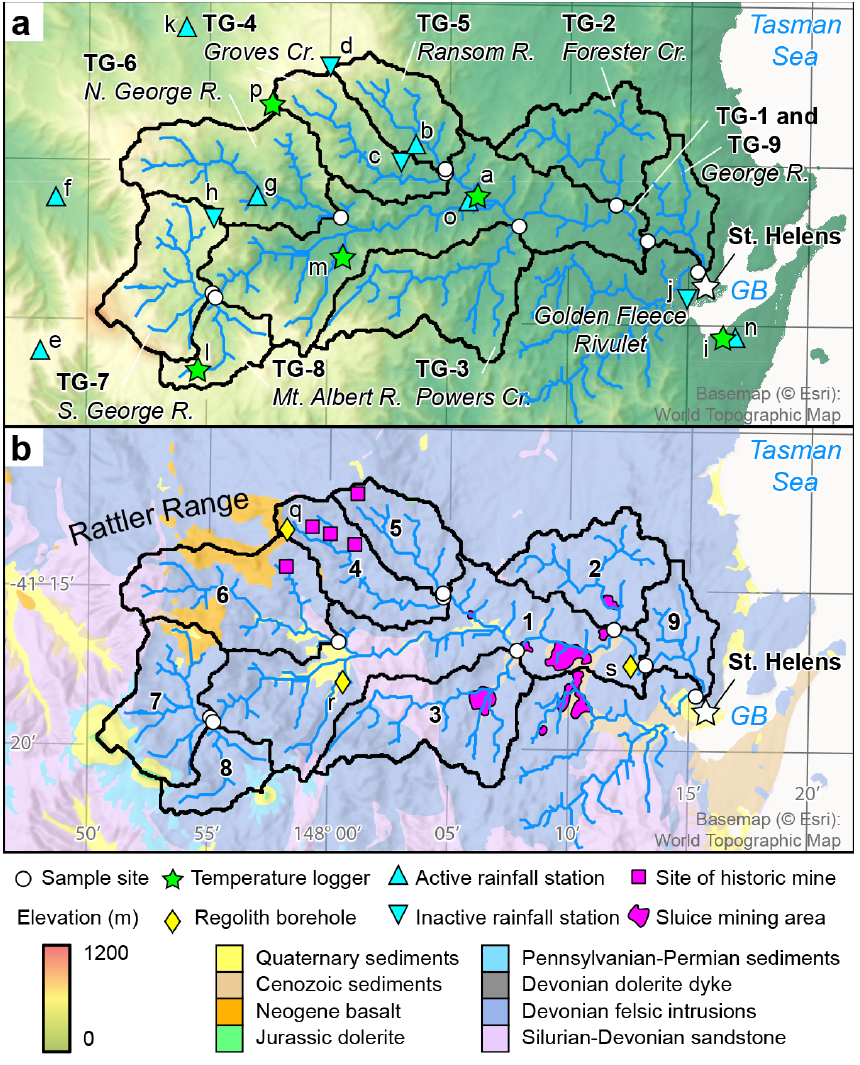
Figure 2. (a) Elevation map of the topography of the George River basin. Sample collection sites (white circles), active and inactive Aus- tralian Bureau of Meteorology rainfall gauging stations (upright and inverted cyan triangles, respectively), and temperature logger locations (green stars) are shown (Webb et al., 2018, 2020). (b) Bedrock geology map of George River shows the widespread occurrence of Devonian felsic intrusions of the Blue Tier Batholith, which underlies the vast majority of the field area. Note that basins TG-2, TG-4, TG-5, and TG-8 are almost entirely underlain by Devonian felsic intrusions. Areas of historic mining are shown (pink squares and polygons; Knighton, 1991), the action of which delivered > 10 6 m 3 to the George River delta in Georges Bay (GB). Locations of boreholes that strike bedrock are shown by yellow diamonds (BoM, 2015). Maps are projected in UTM Zone 55S; coordinates shown in panel (b) are the same for panel (a) . Topographic relief base maps come from the ArcGIS Online World Topographic Map (Esri,